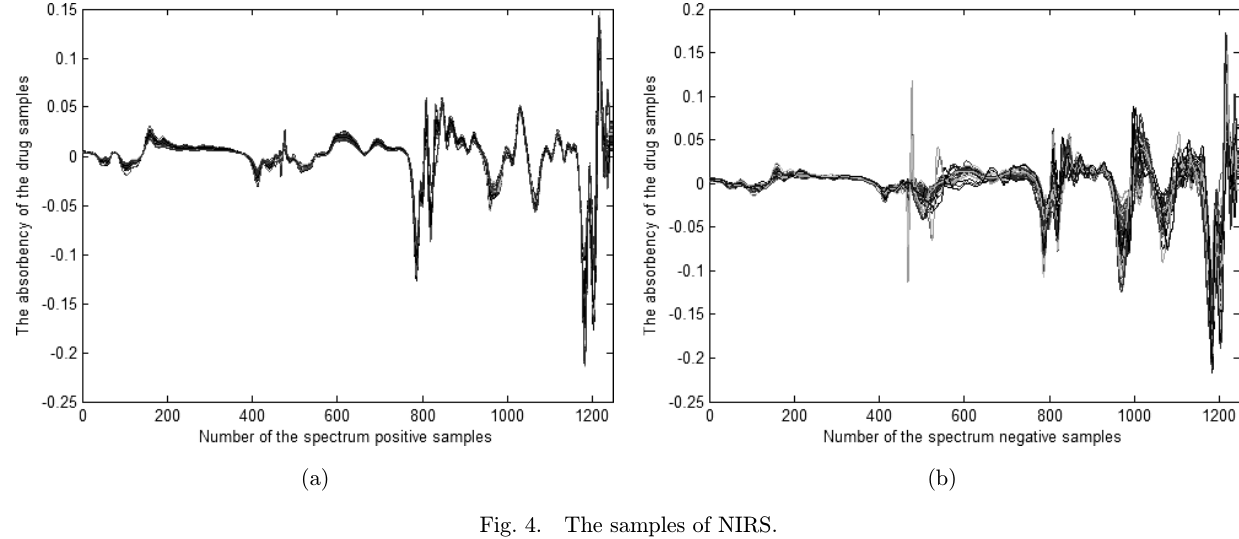
Fig. 4. The samples of